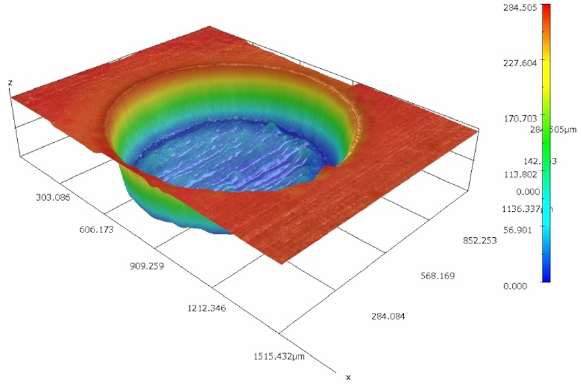
Figure 4: 3D profile of the first sample for trajectory No. 1.